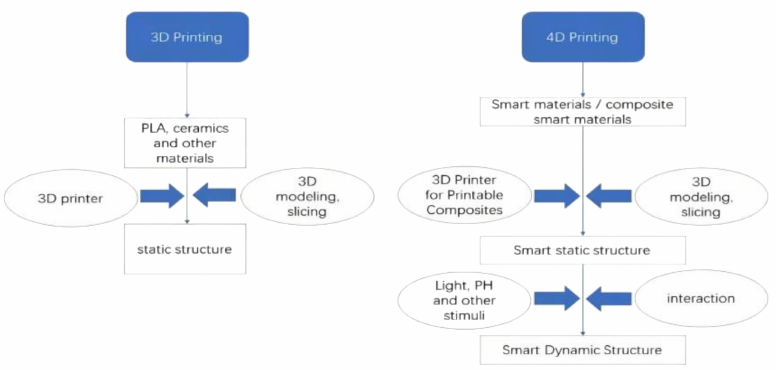
Figure 1. Difference between 3D printing and 4D